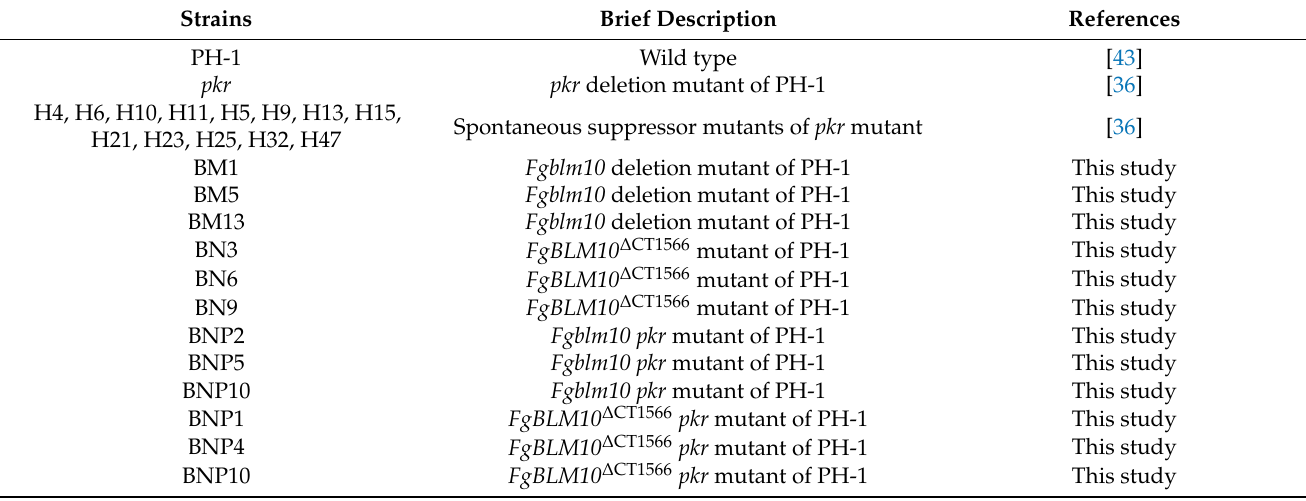
Figure 2. Deletion of the C-terminal region of FgBlm10 partially rescues the defects of pkr. ( A ) Three- day-old PDA cultures of the wild-type strain PH-1 and the pkr , FgBlm10 ∆ CT1566 pkr , and FgBlm10 pkr mutants. ( B ) Conidia of the same set of strains from 5-day-old CMC cultures. Bar = 10 µ m. ( C ) Wheat heads inoculated with the marked strains were examined for head blight symptoms at 14 days post-inoculation (dpi). Black dots mark the inoculated spikelets. Table 2. The wild-type and mutant strains of F. graminearum used in this study. Strains Brief